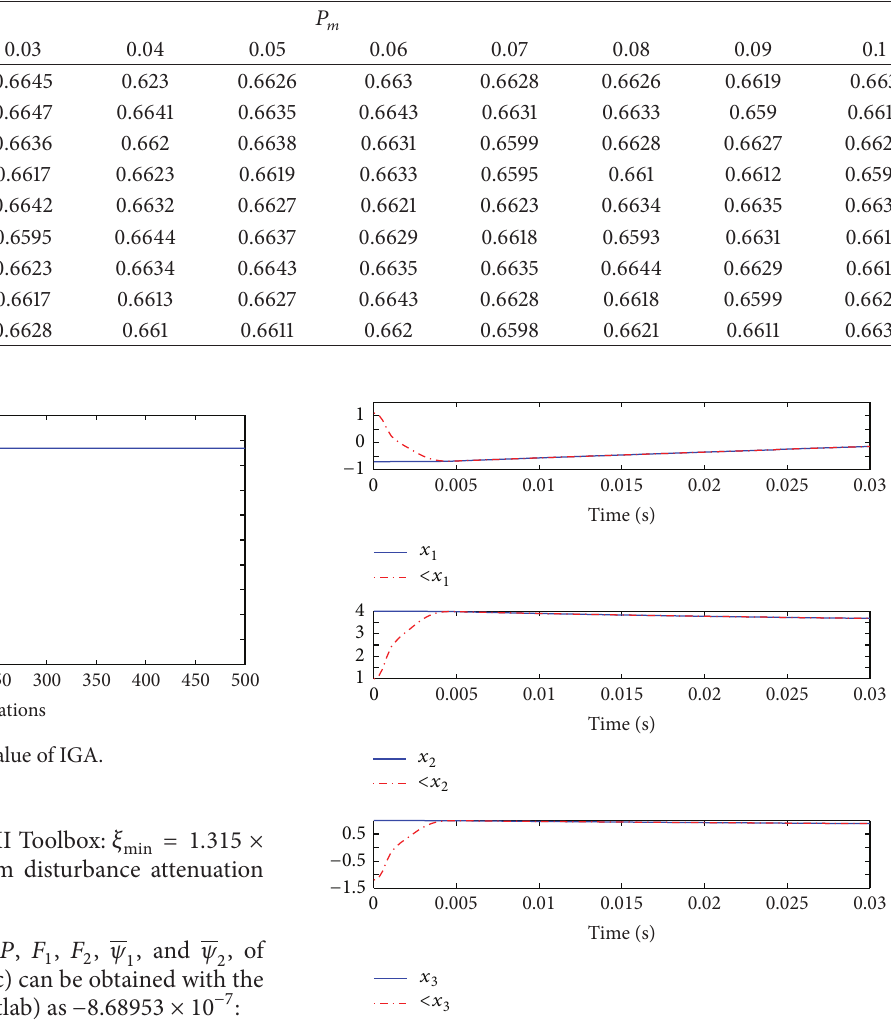
Table 2: IGA experiments with various 𝑤 and 𝑃 𝑚 .